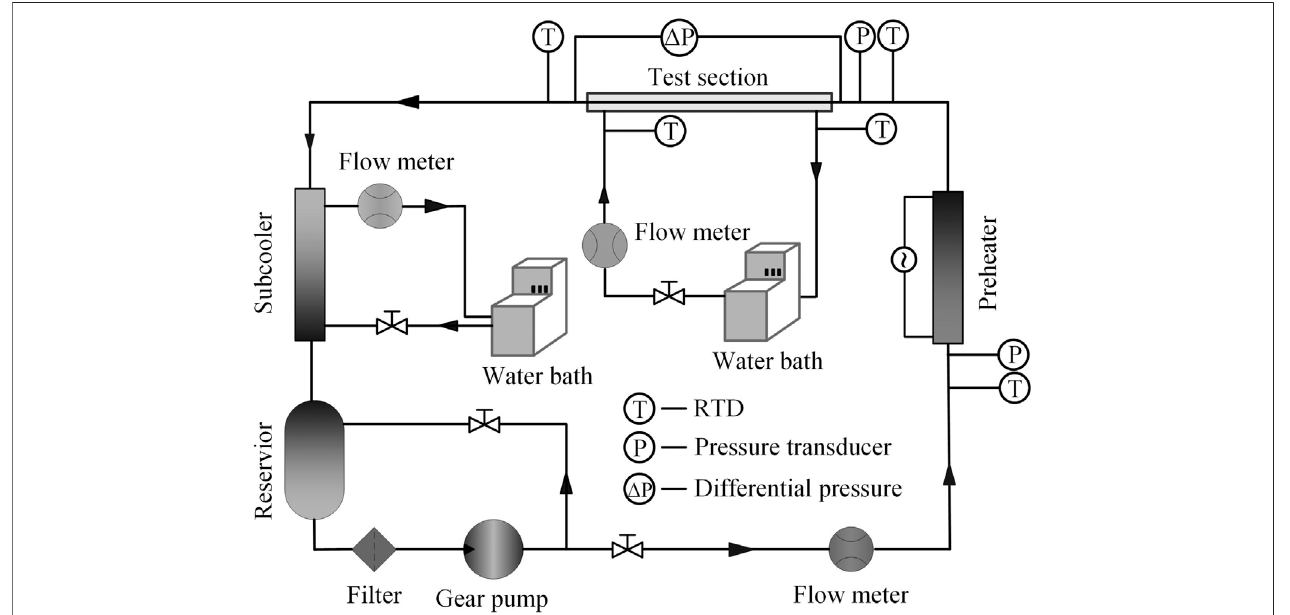
FIGURE 1 | Schematic diagram of the experimental